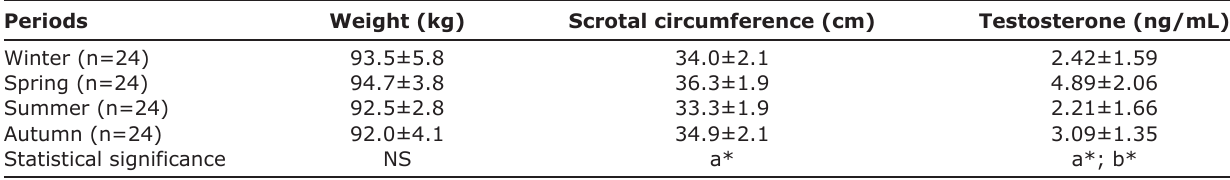
Table-1: Seasonal variations in body weight, scrotal circumference, and serum testosterone. Pearson’s correlation between scrotal circumference and testosterone. Periods